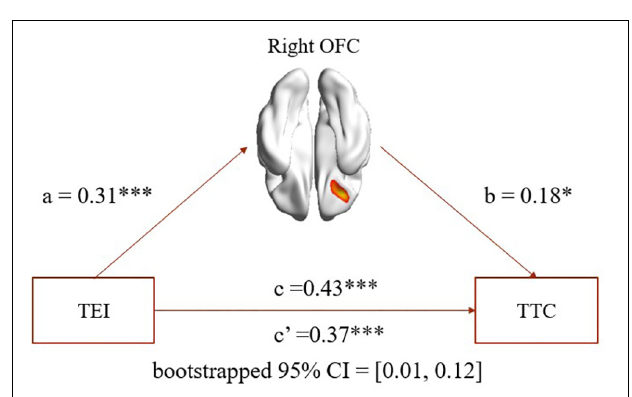
FIGURE 2 | Mediation analysis. Path a, path b, and path c are significant, and path c’ is significantly smaller than path c (bootstrapped 95% CI: 0.01–0.12). The mediation results suggest that rGMV in the right OFC partially mediated the association between TEI and TTC. TEI, total score of emotional intelligence; TTC, total score of trait creativity. ∗ p < 0.05. ∗∗ p < 0.01. ∗∗∗ p <